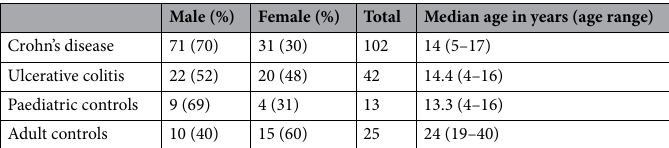
Table 1. Cohort characteristics undergoing plasma periostin